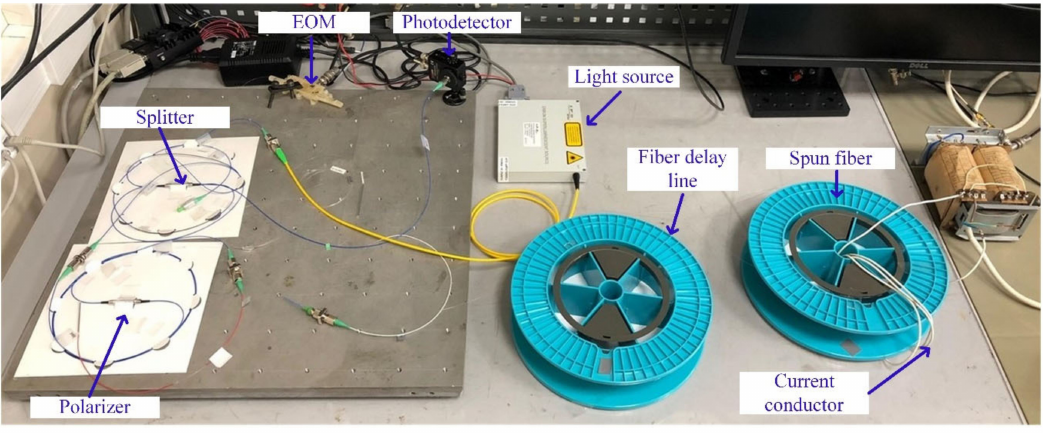
Figure 3. Laboratory model of FOCS.